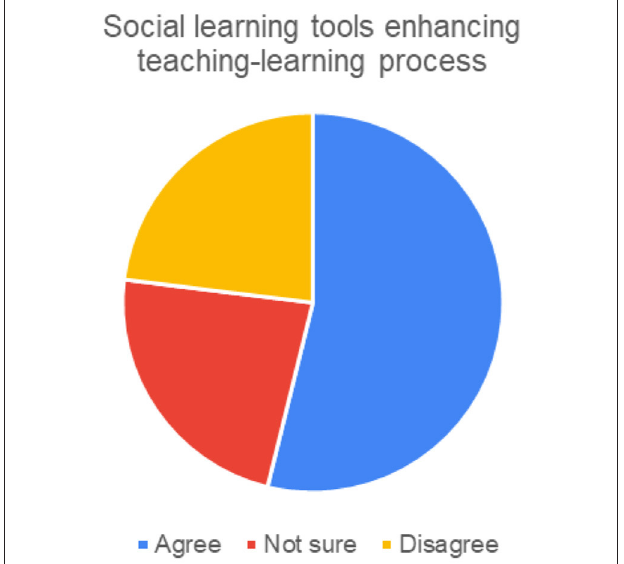
FIGURE 4 | Enhanced learning thought social learning